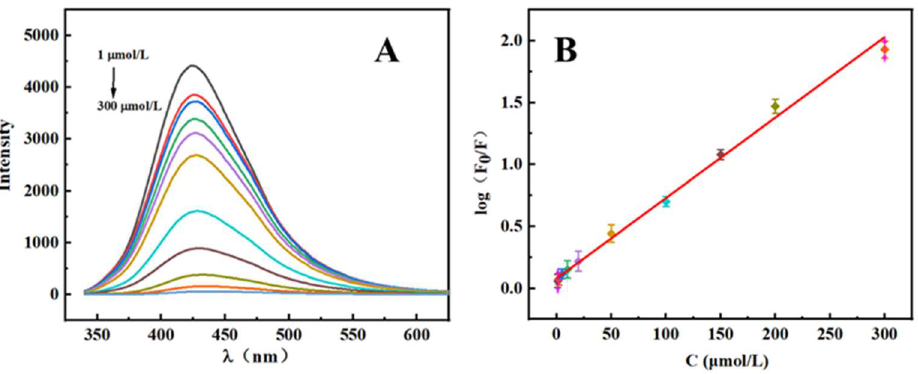
Figure 4. ( A ) Fluorescence response of S, N−CQDs at pH values from 4.5 to 8.5 in the presence of 50 μmol/L MTX; ( B ) fluorescence response of S, N−CQDs at dosage values from 50 to 250 μL in the